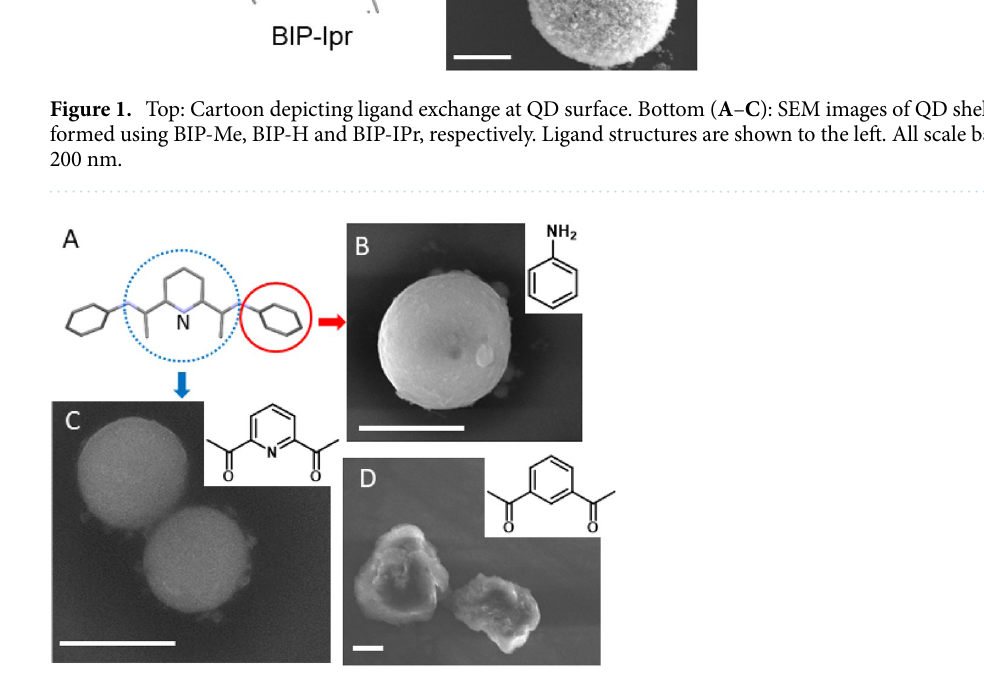
Figure 2. ( A ) Schematic outlining the components of BIP used as control. Dashed and solid circles highlight the aromatic/nonaromatic lewis basic nitrogens (DAP/aniline). SEM images of QD shells formed using ( B ) Aniline, ( C ) 2,6-DAP and ( D ) 1,3-DAB. All scale bars are 1 µm. Chemical structures of the component molecules are shown as accompanying